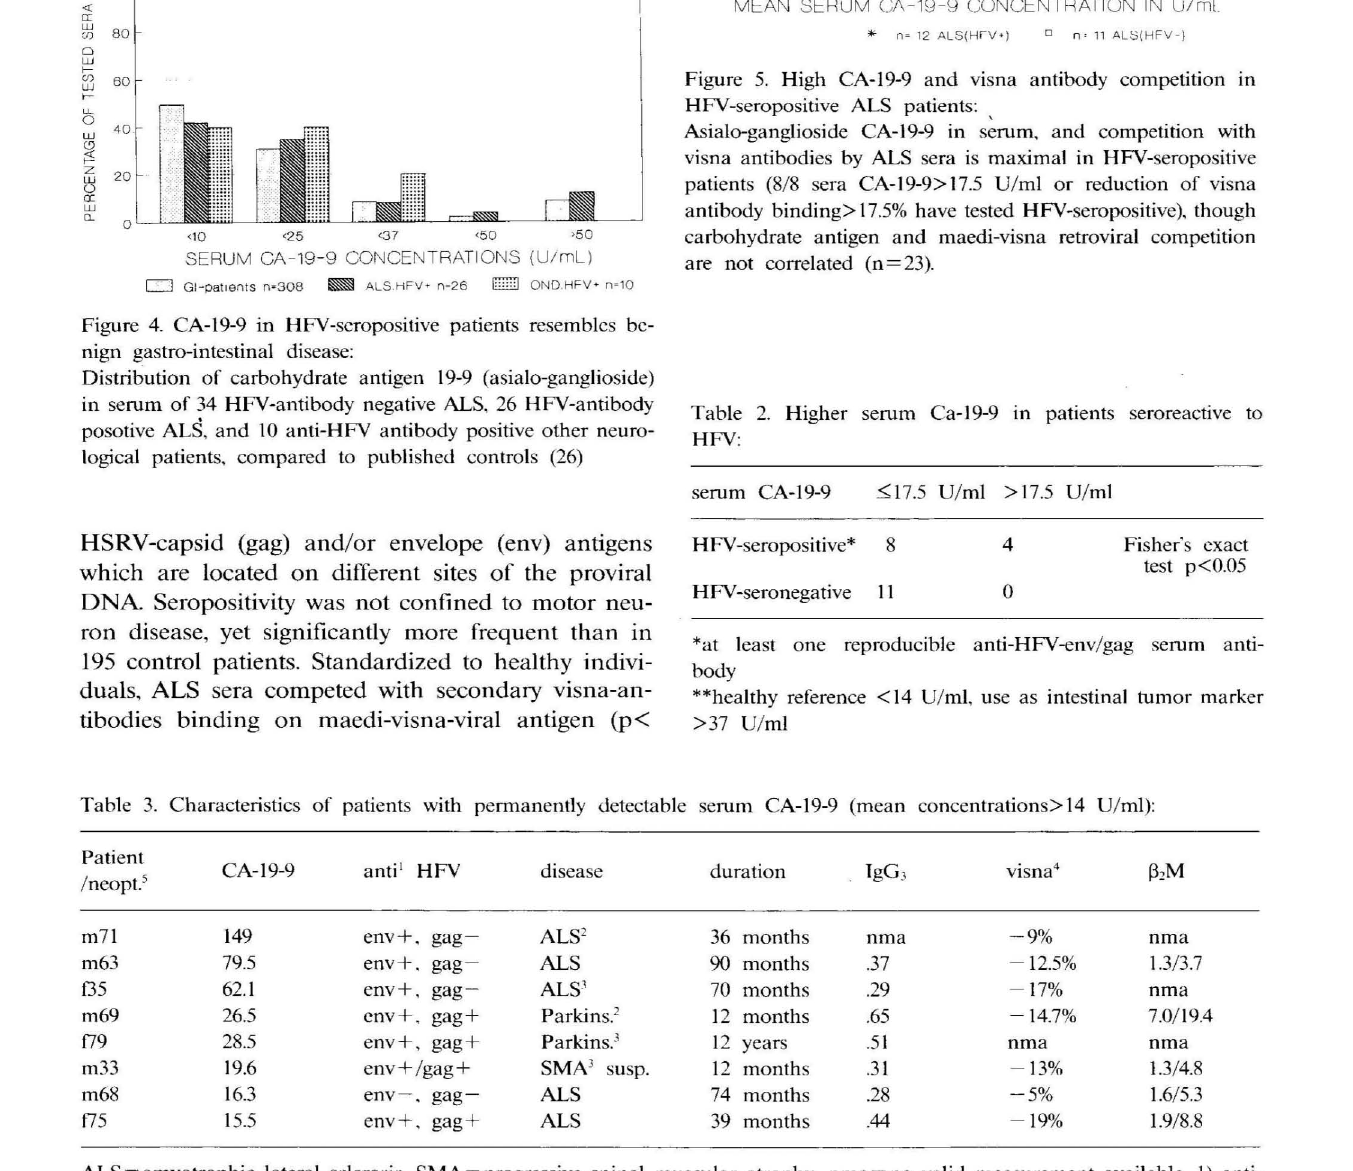
Figure 5. High CA-19-9 and visna antibody competition in HFY-seropositive ALS patients: , Asialo-ganglioside CA-19-9 in serum. and competition with visna antibodies by ALS sera is maximal in HFV-seropositive patients (8/8 sera CA-19-9> 17.5 U/ml or reduction of visna antibody binding> 17.5% have tested HFV-seropositive). though carbohydrate antigen and maedi-visna retroviral competition are not correlated (n=23). Table 2. Higher serum Ca-19-9 in patients seroreactive to